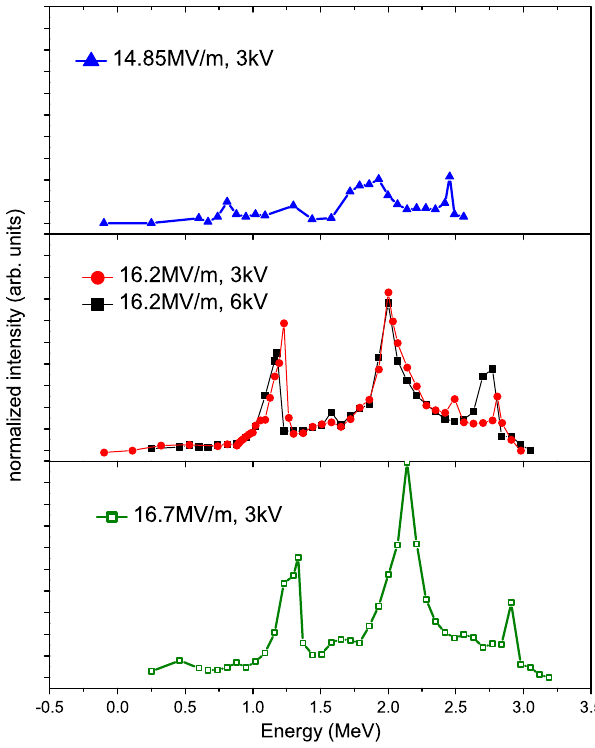
FIG. 9. Energy spectra of the dark current from the SRF gun with Mo cathode plug. The measurement was done with various rf fields E z: and cathode max